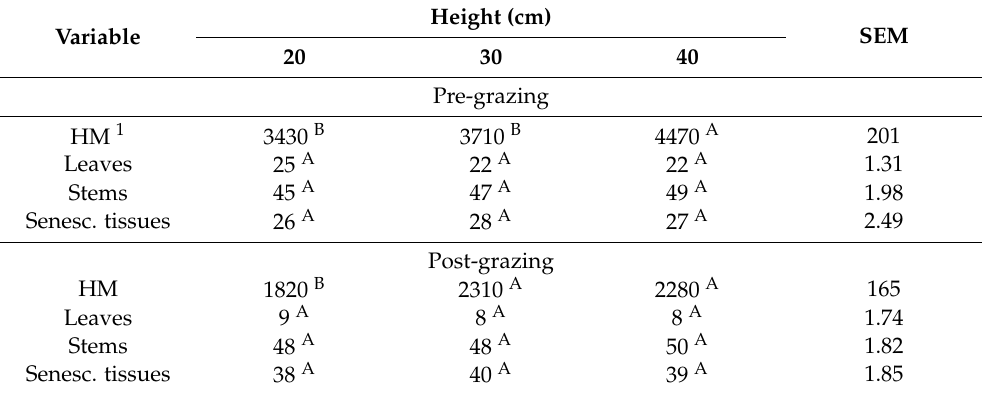
Table 4. Pre- and post-grazing herbage mass (kg DM ha − 1 ; HM) and plant-part composition (leaves, stems, and senescent tissues; %) of tangolagrass pastures subjected to different pre-grazing height targets (20, 30, or 40 cm) and the same intensity of defoliation (40% of the initial height). Height Variable